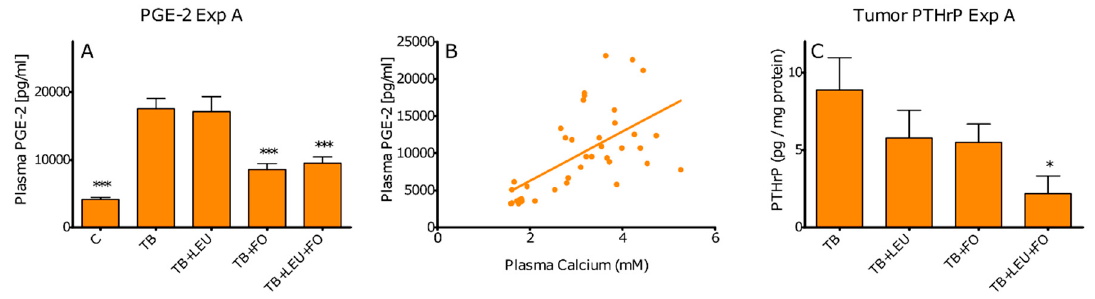
Figure 2. Effect of leucine (LEU), fish oil (FO) and a combination of leucine and fish oil on plasma PGE-2 ( A ); correlation between plasma PGE-2 and plasma Ca2+ levels (Pearson r = 0.6062 with p < 0.0001) ( B ); and tumour PTHrP ( C ). Data represent mean ± SEM. *, ** and *** represent significant differences with TB group (respectively p < 0.05, p < 0.01 and p < 0.001). Table 1. Correlation of plasma calcium levels and organ weights. * and ** represent significant Pearson correlation coefficients of Experiment A (combination vs. separate compounds and controls) and B (total product vs. controls) (respectively, p < 0.05 and p < 0.01). Pearson Correlation Coefficients with Plasma Ca 2+ Levels Experiment A Experiment B